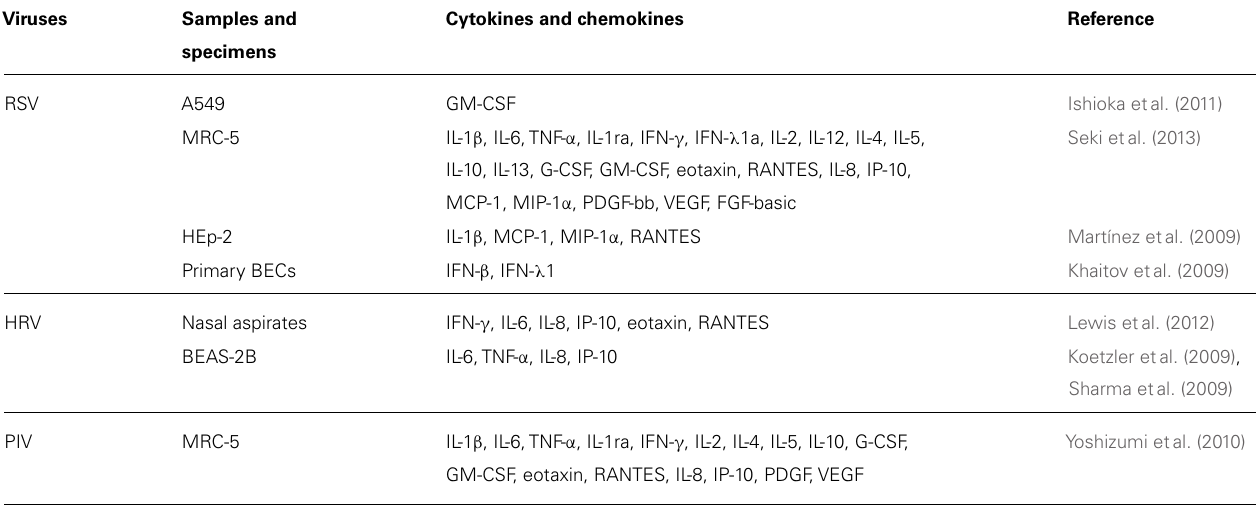
FIGURE 4 | PRRs and virus infection-associated signaling pathways. The innate immune response to the fusion protein of an important respiratory pathogen of humans, RSV, is mediated byTLR4.The RSV F protein induces translocation ofTLR4 to the endosome together with TRAM.TLR3 is expressed in intracellular endosomes and responds to the presence of double-stranded RNA (dsRNA), which forms as a product of the replication of the majority of RNA viruses such as RSV.TLR3 andTLR4 activateTRIF-dependent signaling, which activates NF- κ B and IRF-3,